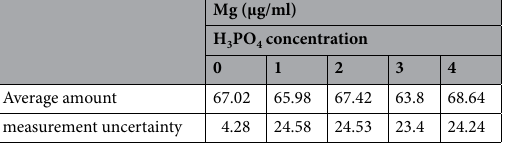
Table 10. Determined amount of Mg in samples in the presence of bacteria after 24 h of the experiment.